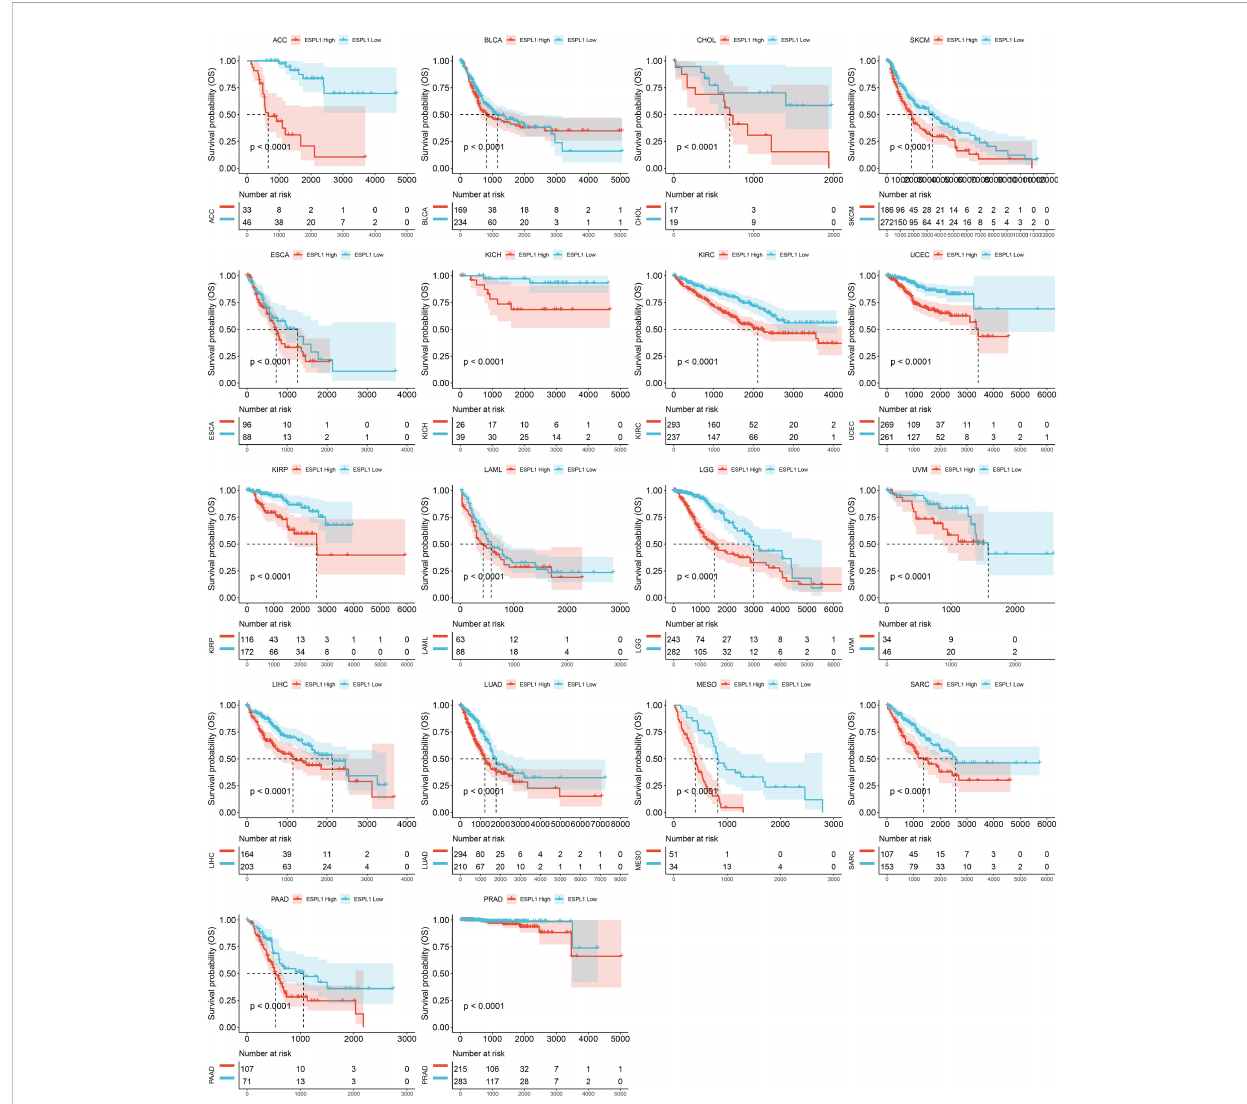
FIGURE 3 Kaplan-Meier plots with statistically signi fi cant differences in overall survival analysis by best-cut off value method for